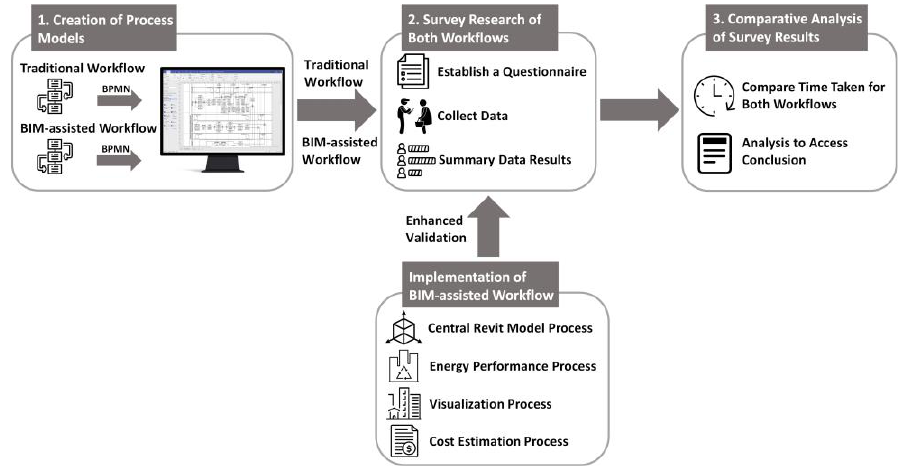
Figure 1. Overall process of methodology.